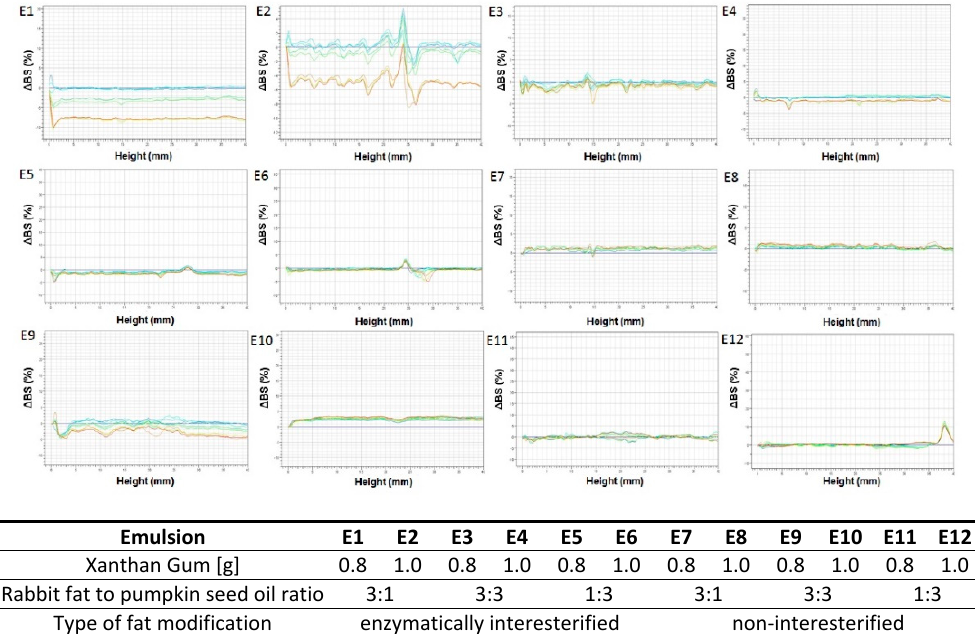
Figure 4. Delta backscattering profiles ( Δ BS) as a function of the sample cell height (mm) for emulsions E1–E12 stored 30 days. Lines correspond to subsequent measurements performed in 3–4 days intervals, where blue line is Day-0 and red line is Day-30.